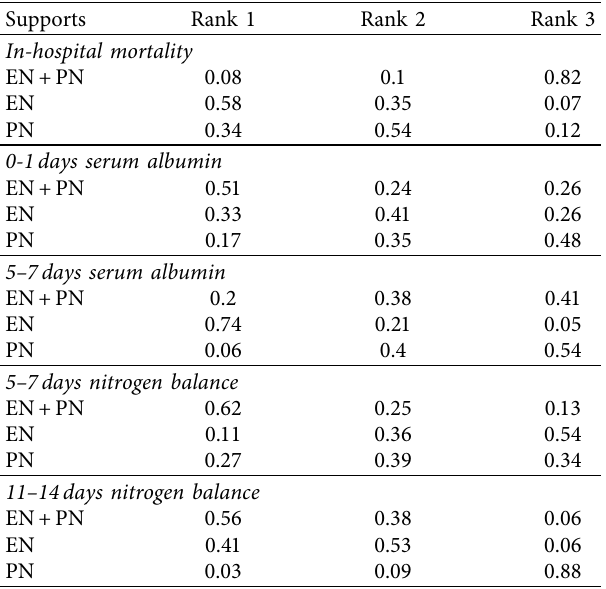
Table 2: Results of the rank test for diferent nutritional supports.